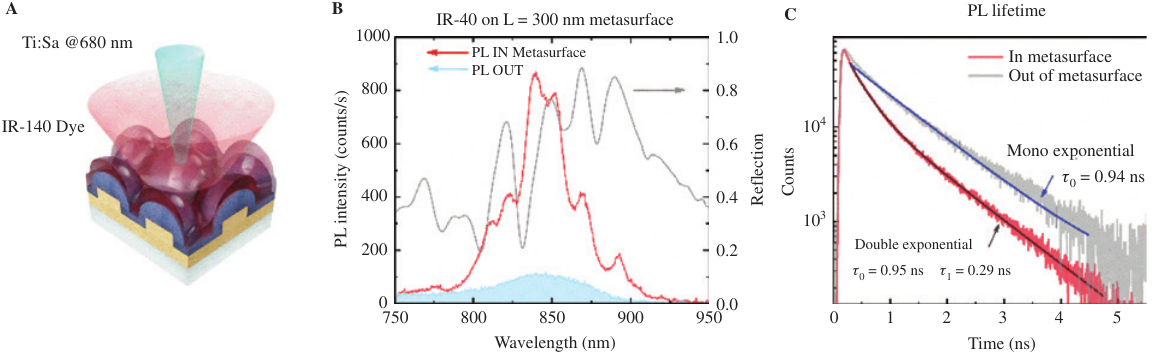
Figure 4: Photoluminescence (PL) enhancement of a near infrared (NIR) dye on the metasurface. (A) Scheme of PL measurement configuration. The emission of the spin coated dye on the metasurface (L = 300 nm) is excited by a Ti:sapphire laser and collected in reflectance mode by a 5 cm lens. (B) PL intensity of the dye placed on the metasurface (red) vs. on a planar silicon substrate (blue); the reflection of the nanostructured substrate (gray) is included for comparison. (C) Spectrally integrated time-resolved PL decay for emitters deposited on the metasurface (red) and on the reference substrate (grey) with their corresponding fitting